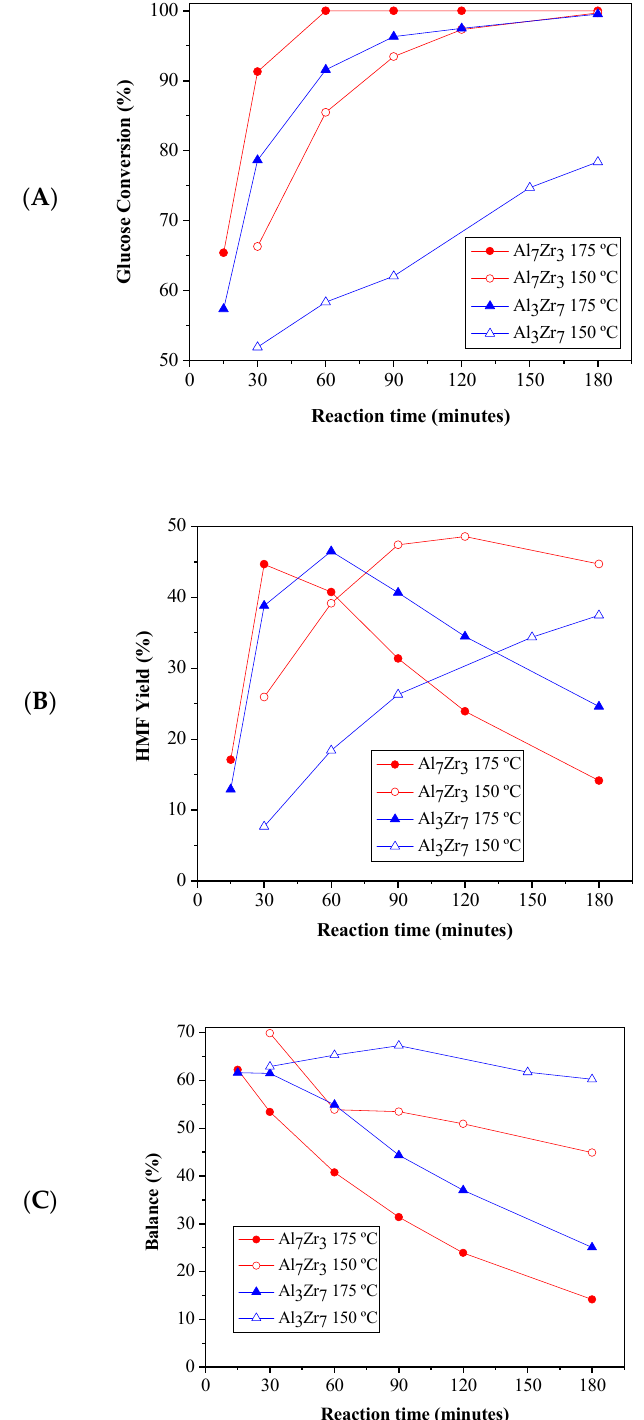
Figure 7. Effect of reaction temperature on glucose conversion ( A ), HMF yield ( B ), and carbon balance ( C ) as a function of reaction time, in the presence of Al 7 Zr 3 and Al 3 Zr 7 catalysts. Experiments were represented with full and empty symbol for 175 °C and 150 °C, respectively (0.65 g CaCl2 ·g aq.sol. − 1 and glucose/catalyst weight ratio of 3).